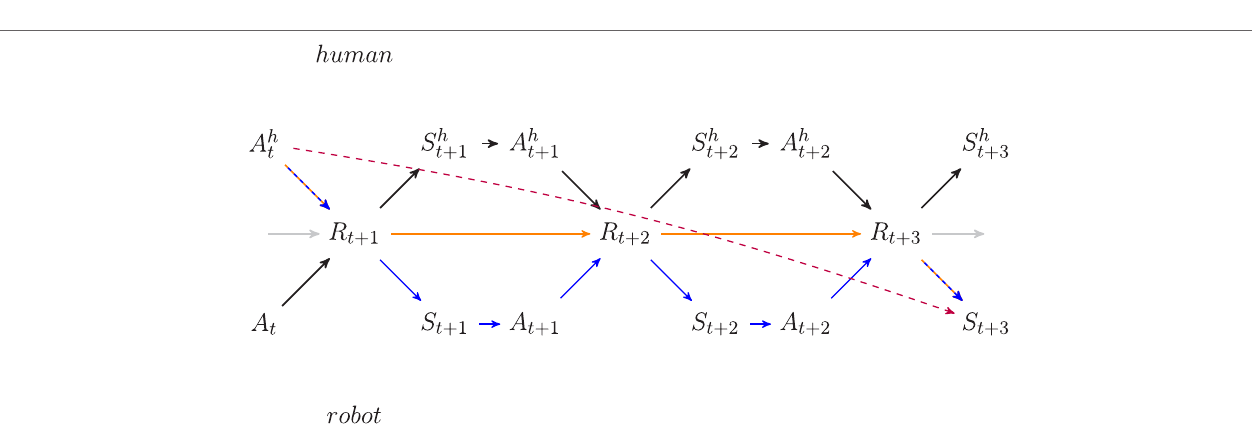
FiGUre 9 | The time-unrolled perception–action loop of two agents, colored to visualize the different pathways potential causal flow can be realized. The red dashed line indicate the causal flow from the human actuator A th at time t to the robot’s sensor variable S t + 3 at time t + 3, which contributes to human-to-robot transfer empowerment. This potential causal flow can be realized by direct human influence on the environment R (one exemplary path shown in blue). Alternatively, the human can influence the environment R , and the robot can then perceive this change, react to it by choosing an appropriate action A and thereby influence its perceived environment itself. One exemplary path is shown in orange. The dashed arrows are those used by both pathways.